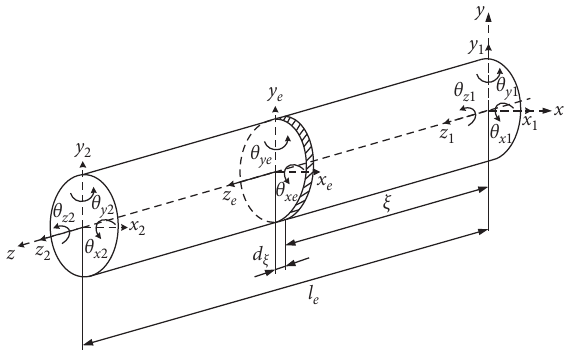
Figure 2: Diagram of Timoshenko beam